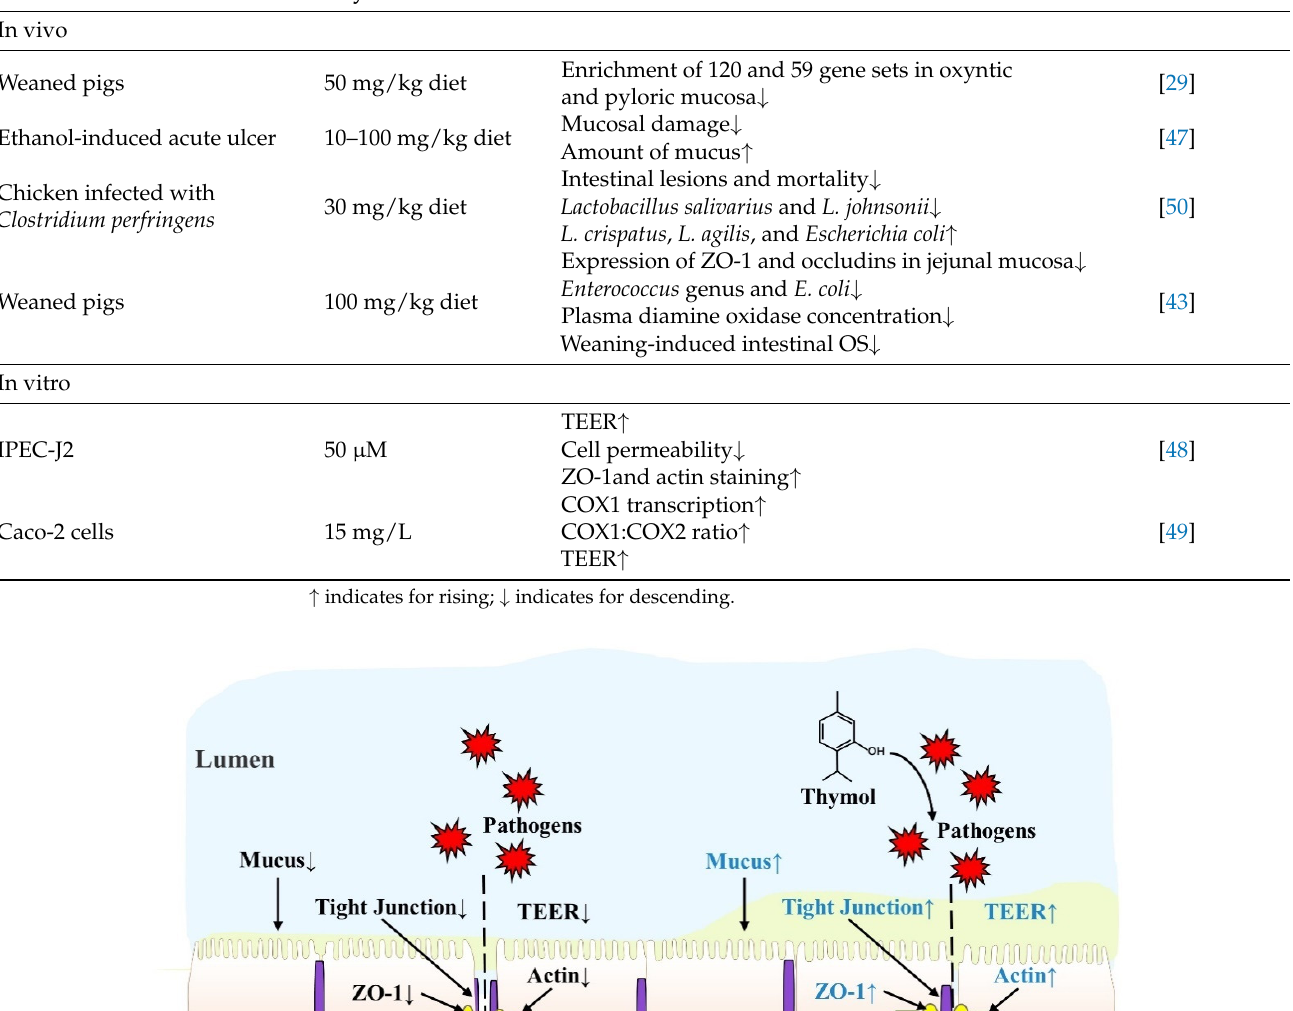
Table 1. Protective function of thymol on the intestinal barrier.